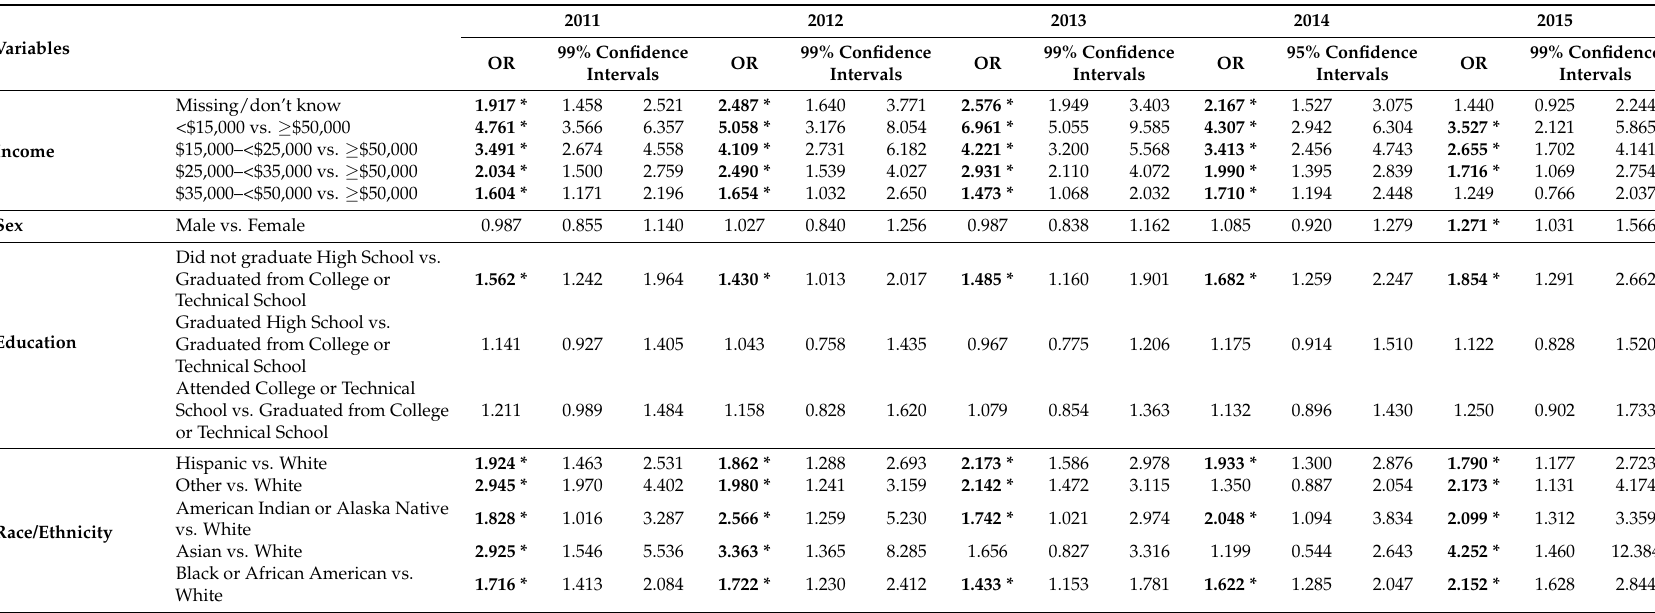
Table 5. Adjusted Analysis for Forgone Care among individuals aged 65 years of age and